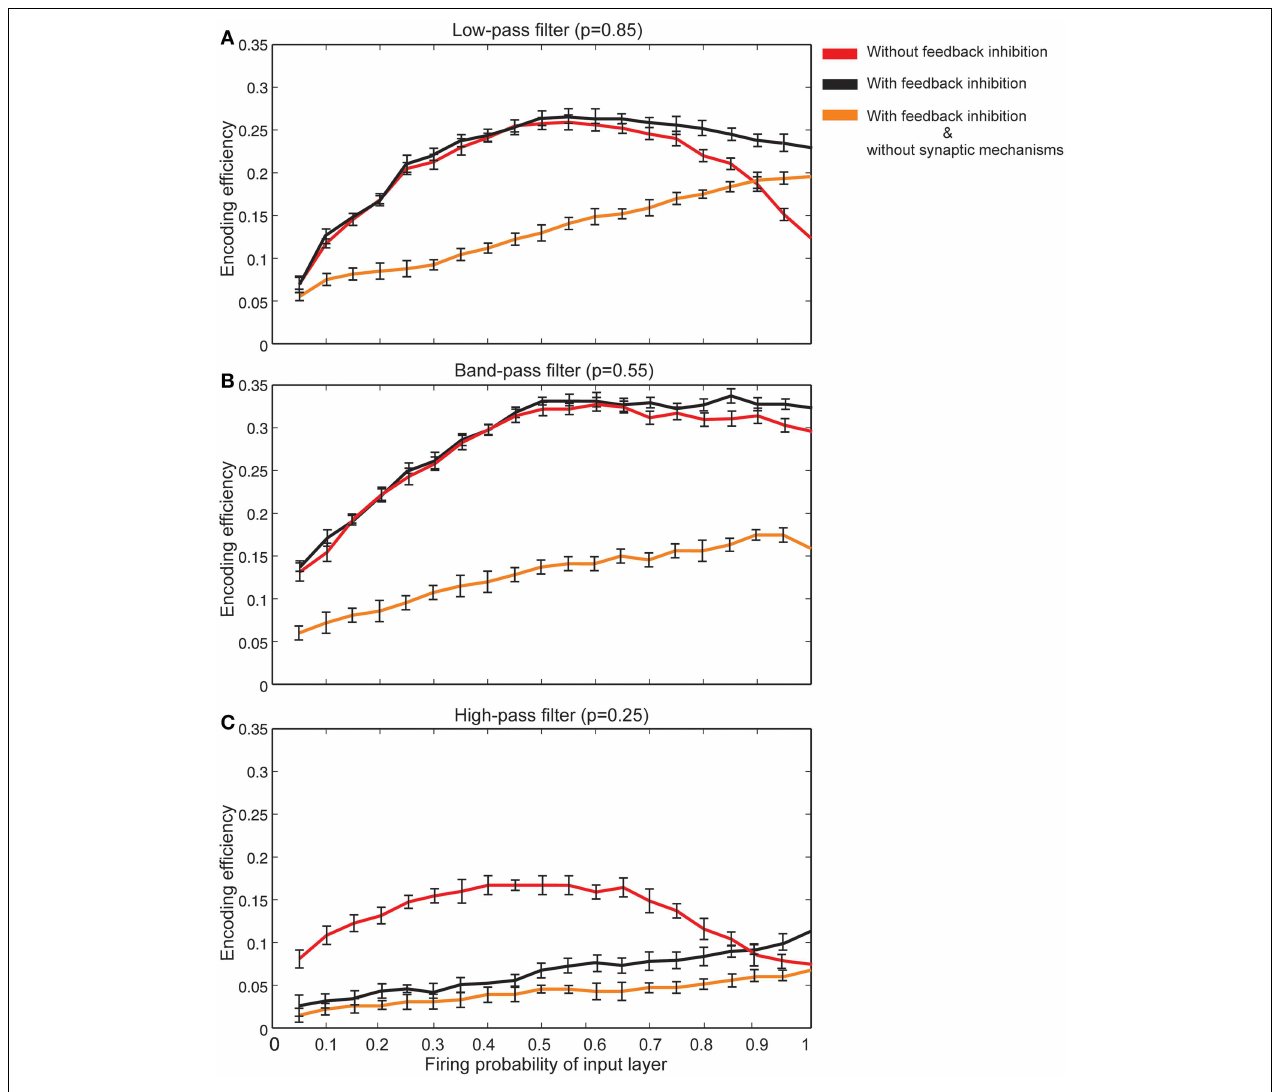
Synapses as band-pass filters. Initial release probability was set to 0.55. In comparison to low-pass filters, in the presence of feedback inhibitory neuron the efficiency of a single neuron to encode stimulus is higher. (C) Synapses as high-pass filters. Initial release probability was set to 0.25.Neuron shows low levels of encoding efficiency with or without feedback inhibitory